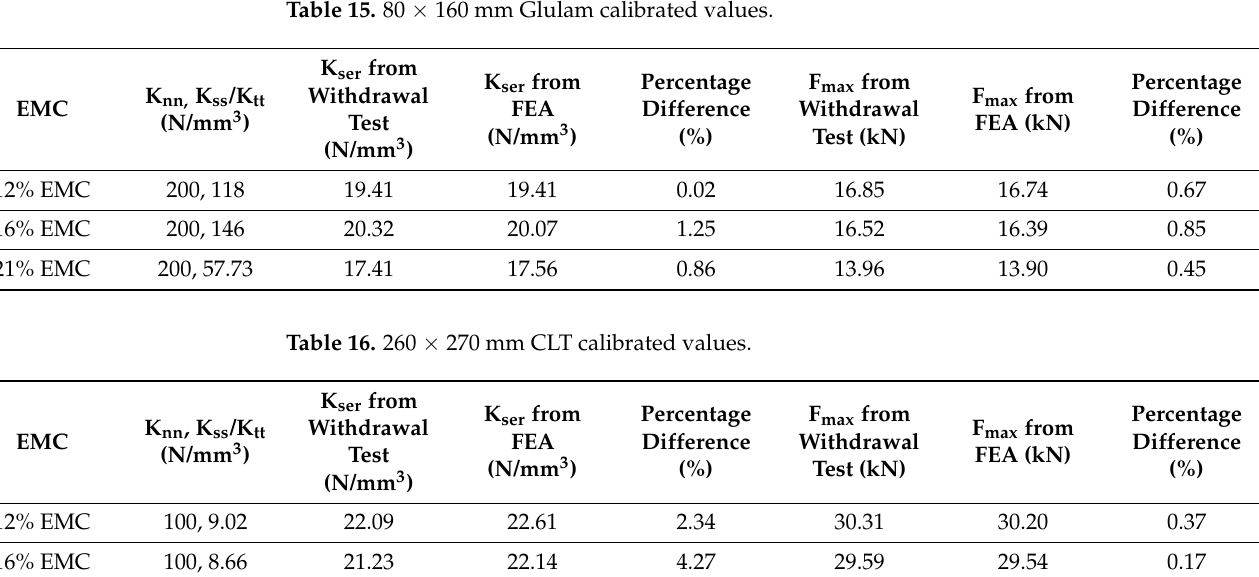
Table 15. 80 × 160 mm Glulam calibrated values.